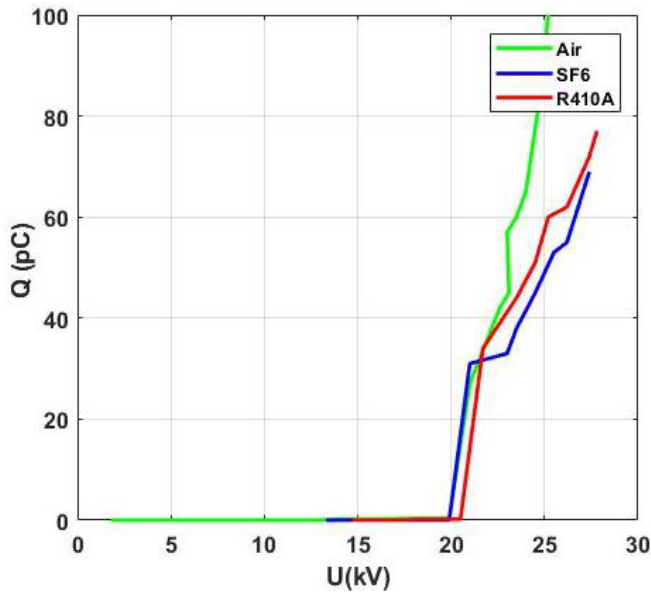
Figure 7. Partial Discharge curve for air, SF6 and R410A.